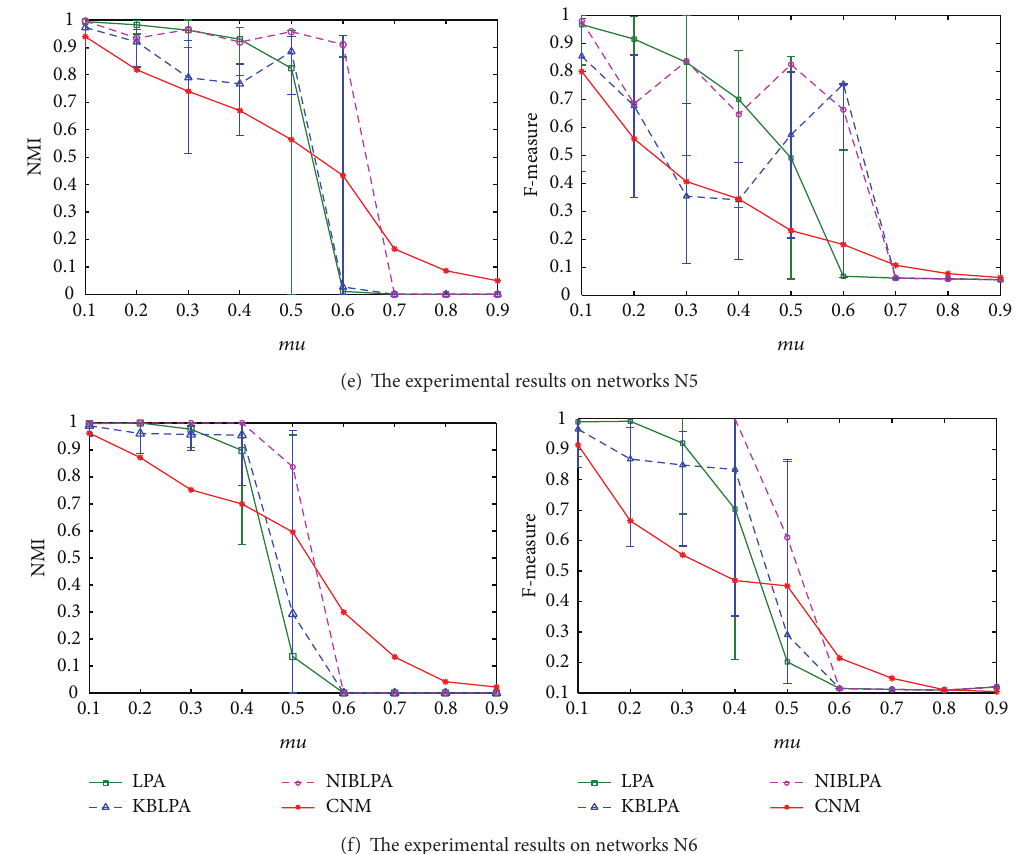
Figure 6: The results of the four algorithms on LFR benchmark networks.